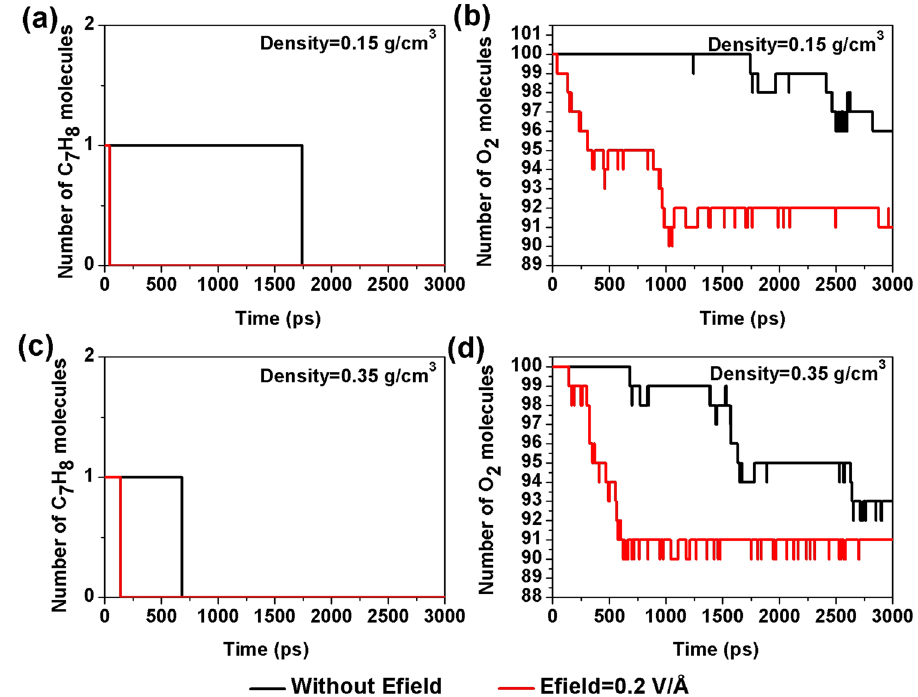
Figure 3. Evolution of the toluene and oxygen molecules at density ρ = 0.15, 0.35 g/cm 3 , Efield = 0, 0.2 V/Å